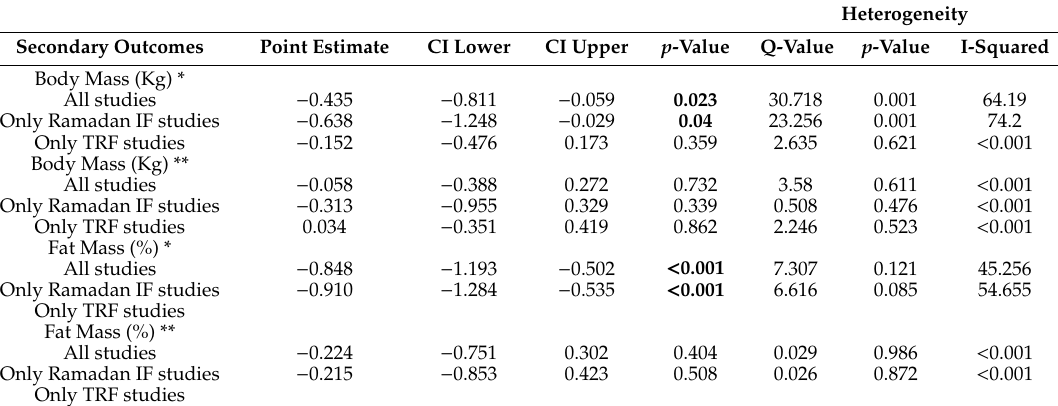
Table 4. Meta-analytic results for the e ff ects of intermittent fasting on body